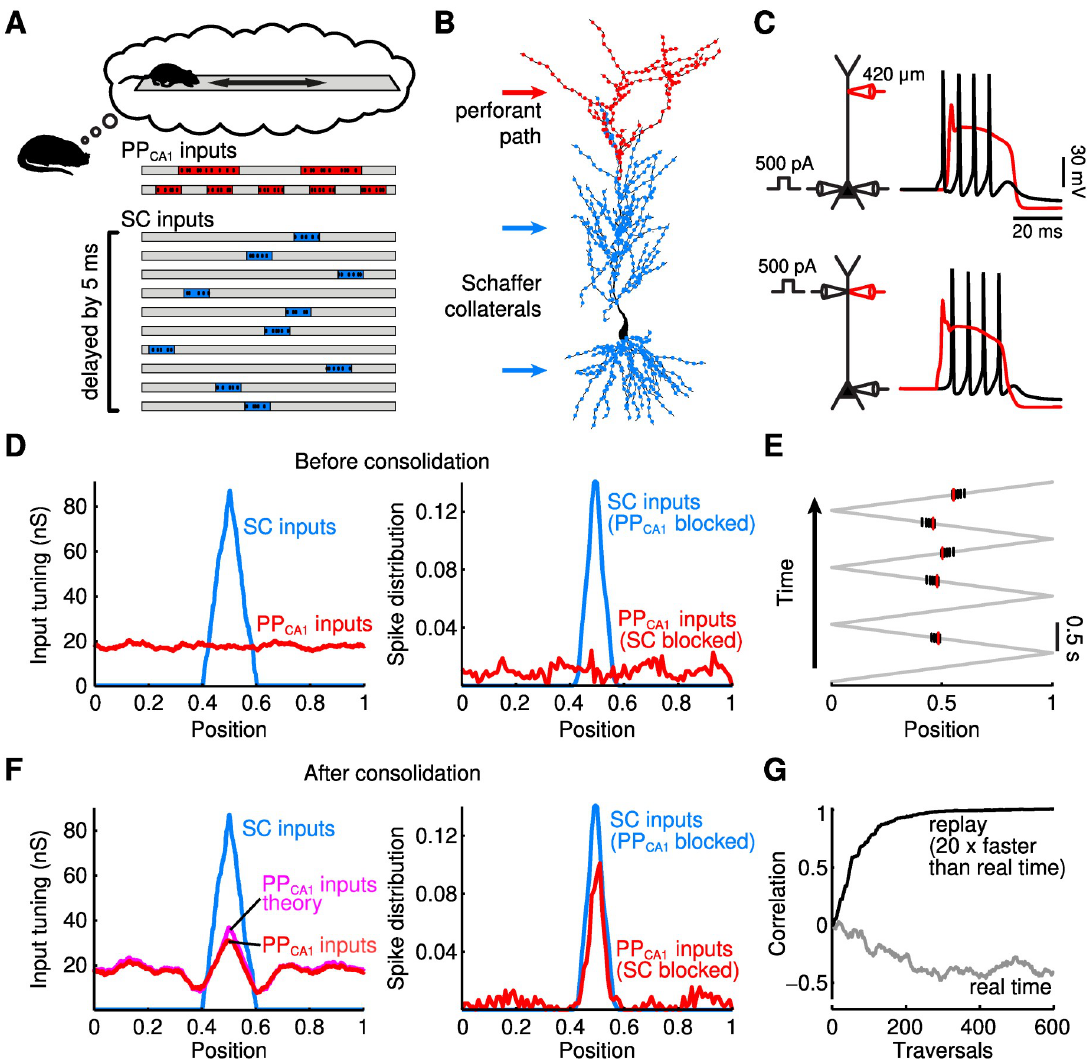
Fig 3. Consolidation of spatial representations. (A) Replay of PP CA1 and SC activity during sleep. 500 PP CA1 inputs and 2500 SC inputs are spatially tuned on a linear track with periodic grid fields (top, red) and place fields (bottom, blue). Spiking activities are independent Poisson processes (10 spikes/s) inside place/grid fields, otherwise silent. SC activity is delayed by 5 ms. (B) Multi-compartmental model of a reconstructed CA1 pyramidal neuron (see Methods). PP CA1 and SC inputs project to distal apical tuft dendrites (red dots) and proximal apical and basal dendrites (blue dots). (C) Active neuron properties. Top: somatic sodium spike (black) propagates to the distal tuft and initiates a dendritic calcium spike (red) and further sodium spikes. Bottom: dendritic calcium spike leads to bursts of somatic spikes. (D) Spatial tuning before consolidation. SC provides place field-tuned input to the CA1 cell (left, blue), which yields spatially tuned spiking activity (right, blue); PP CA1 input is not spatially tuned (left, red), and (alone) triggers low and untuned spiking activity (right, red). (E) Somatic and dendritic activity during consolidation. During replay, SC input generates backpropagating sodium spikes (black vertical lines) that generate dendritic calcium spikes (red). (F) After consolidation. Spatial tuning is consolidated from the indirect SC pathway into the direct PP CA1 pathway. Left: spatial tuning of total PP CA1 input (red) approaches theoretically derived PP CA1 input tuning (magenta; see Methods). Right: CA1 output is place field-tuned through either SC or PP CA1 input alone. (G) Evolution of correlation between actual and optimal PP CA1 input tuning (see F) for replay speeds corresponding to hippocampal replay events (black) and real-time physical motion (grey). Position in D, E, and F normalized to [0, 1]. (Fig 3B) that was endowed with active ion channels supporting backpropagating action poten- tials and dendritic calcium spikes (Fig 3C, Methods).